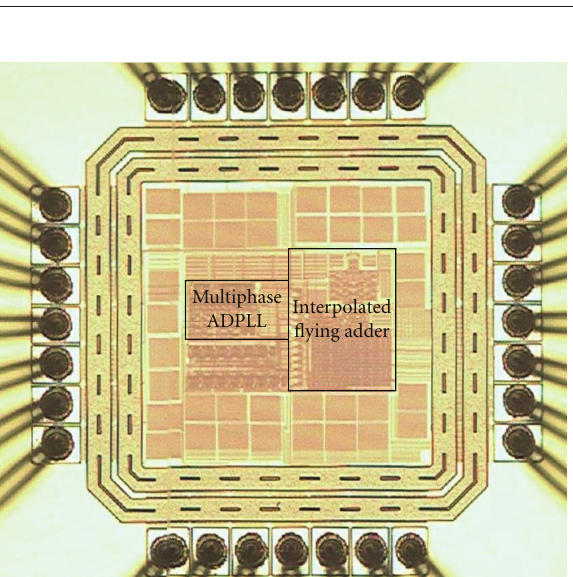
Figure 15: Microphotograph of the proposed all-digital frequency synthesizer using an interpolated flying